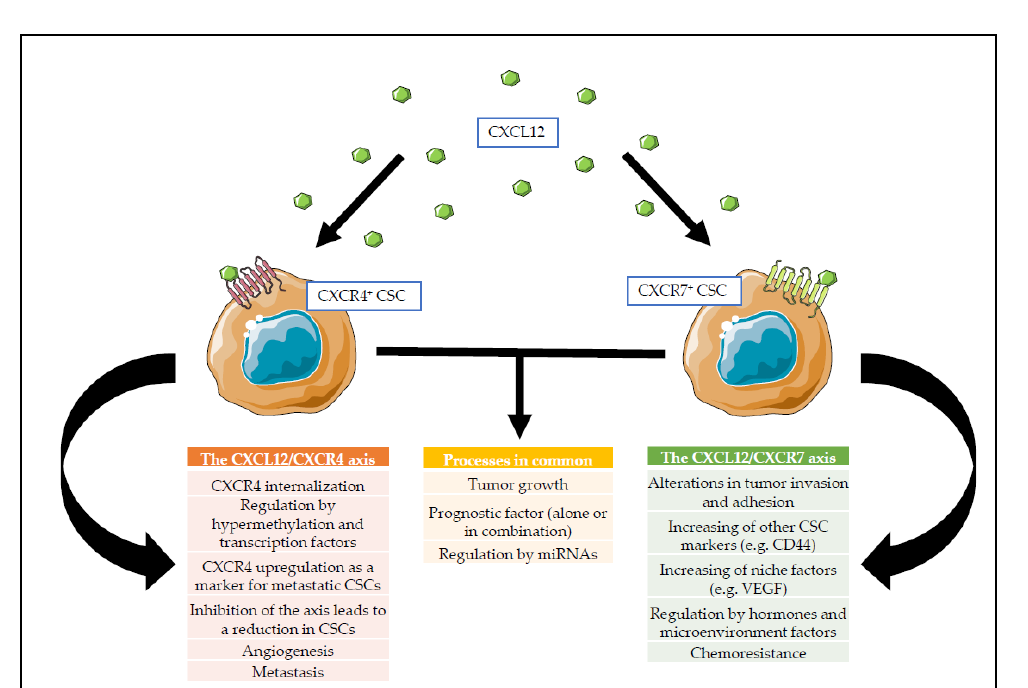
Figure 2. Comparison of the effects and processes initiated after the interaction between TME CXCL12 and CSCs, which express CXCR4 and/or CXCR7 on their cell surface.